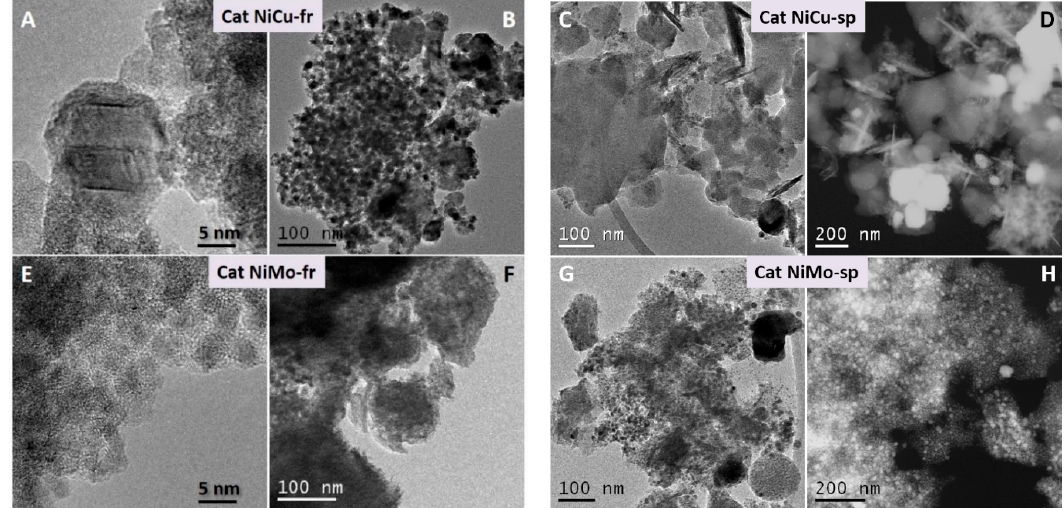
Figure 9. TEM micrographs of catalysts NiCu / SiO 2 -ZrO 2 ( A ) and ( B )—fresh reduced; ( C ) and ( D )—after hydrotreatment of PS fraction and NiMo / SiO 2 -Al 2 O 3 ( E ) and ( F )—fresh reduced; ( G ) and ( H )—after hydrotreatment of PS fraction. Micrographs ( D ) and ( H ) were recorded in a dark field regime (TEM images of fresh samples are taken from Reference [25], and added here for proper comparison of data for the spent